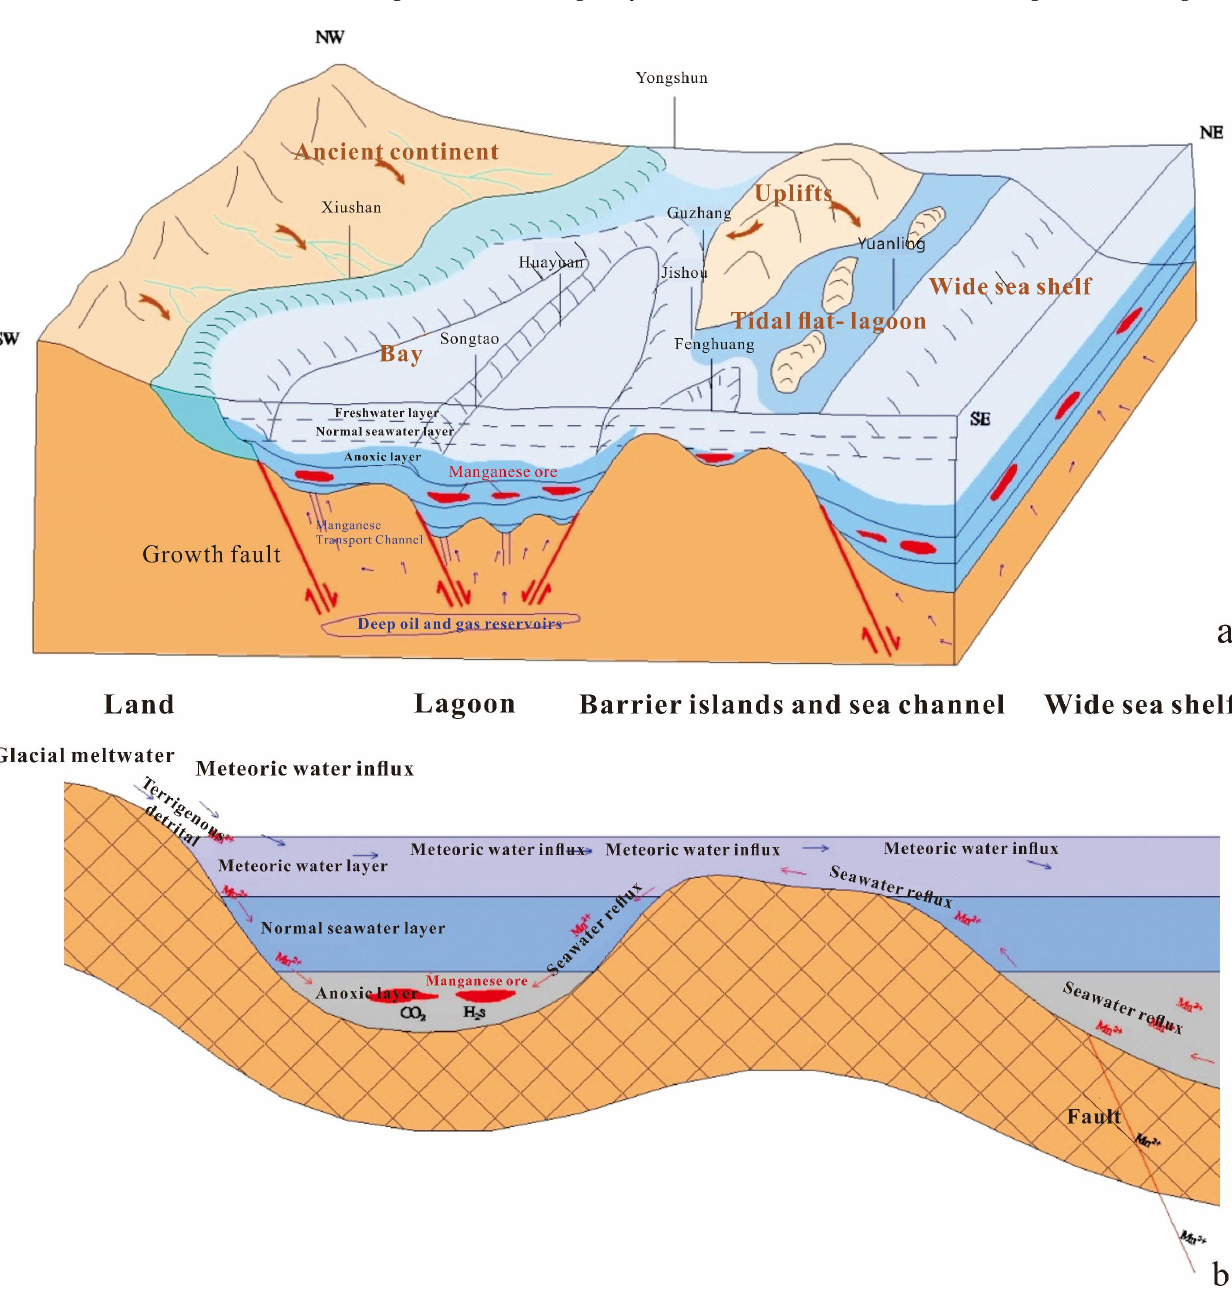
Figure 3. ( a ) The metallogenic model of the regional manganese ore. ( b ) The evolutionary model of the regional sedimentary manganese basin [28].